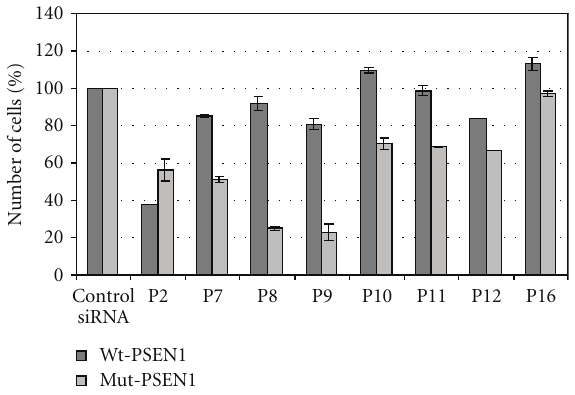
Figure 5: Results of flow cytometry assay. HeLa cells were cotrans- fected by pEGFP-Wt-PSEN1(400) or pEGFP-Mut-PSEN1(400), pDsRed-N1, and indicated siRNAs, using Lipofectamine 2000 as a transfection reagent (details described in Section 2). HeLa cells containing both, the EGFP and RFP fluorescence, were counted in the BD FACS Calibur Flow Cytometry System (Becton Dickinson) using Ar-ion laser (488 nm). Fluorescence dot plots were generated using Cell Quest software.